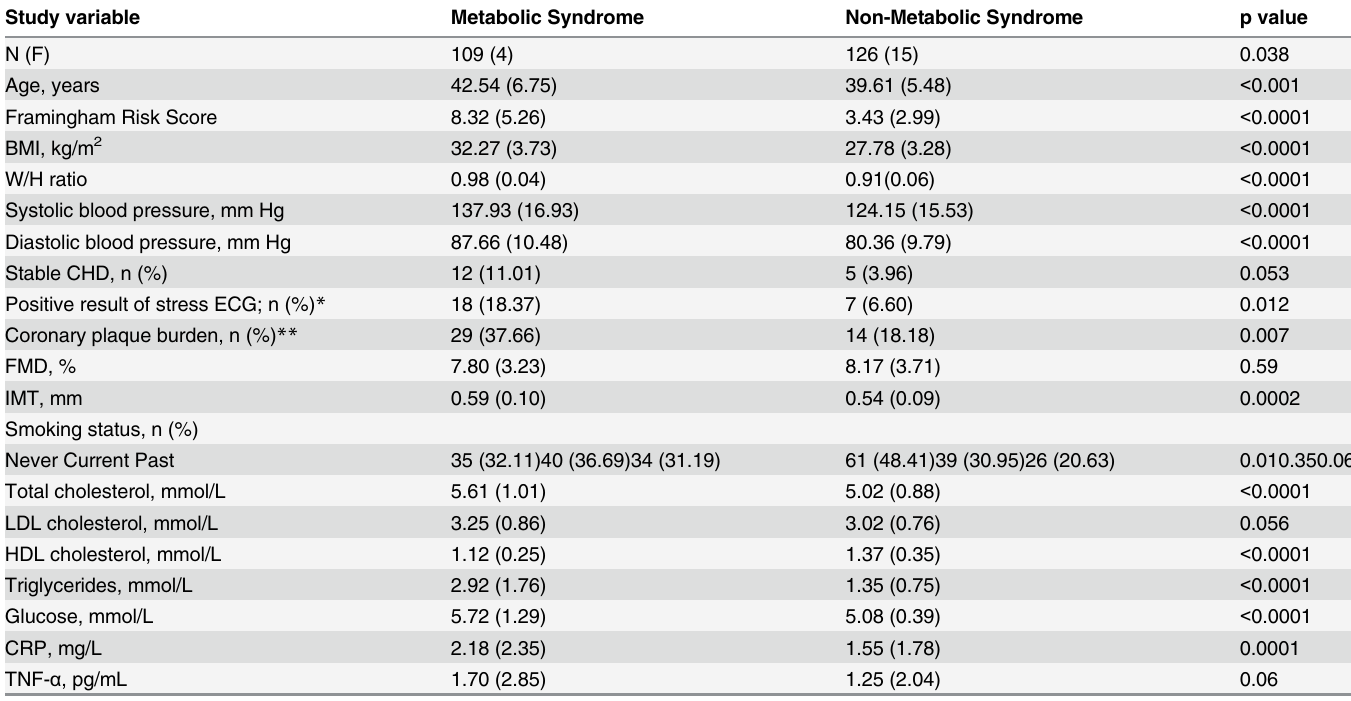
Table 2. Characteristics of the study subjects stratified by metabolic syndrome status.